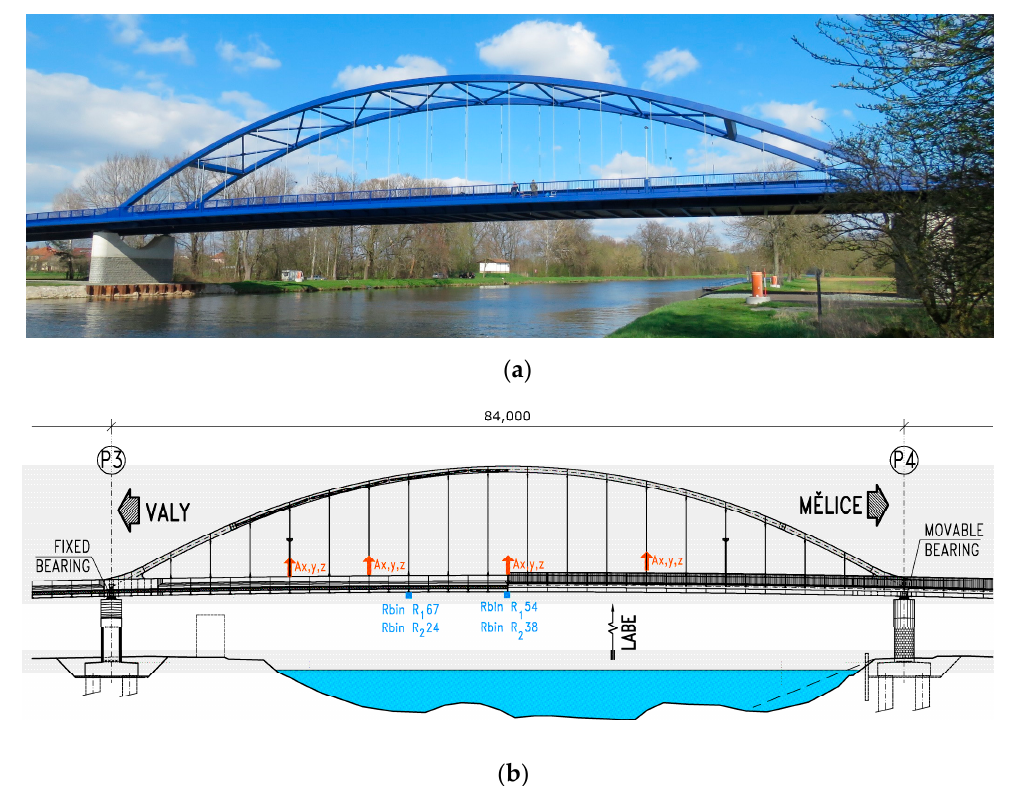
Figure 10. Side view on the third span of the tied-arch bridge ( a ) photo; ( b ) schematic with marked positions of accelerometers and Rbins.